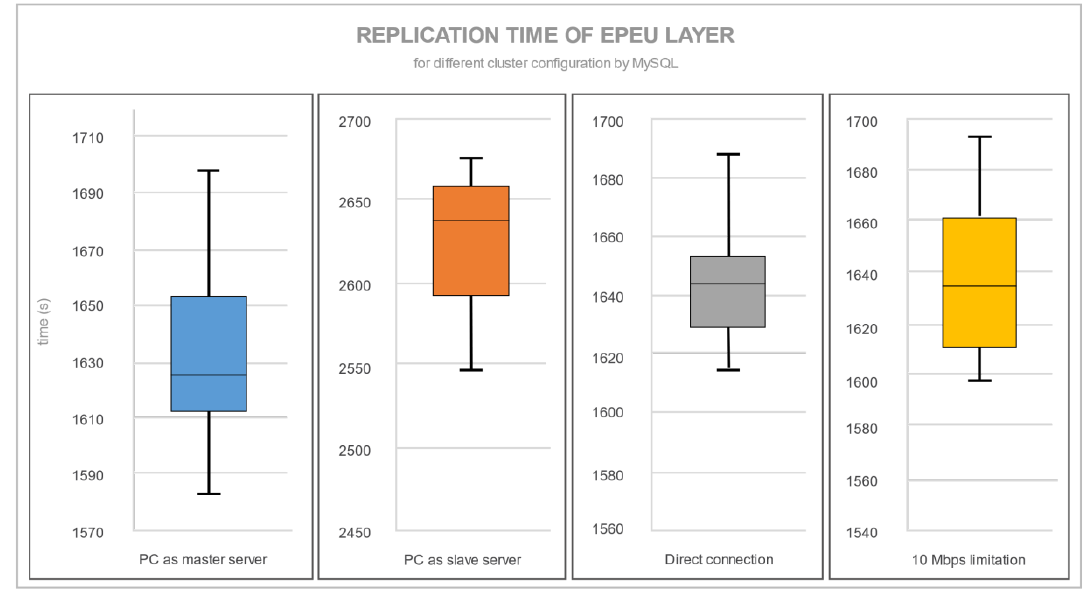
Figure 11. Replication time of the EPEU layer for different cluster configurations by MySQL.